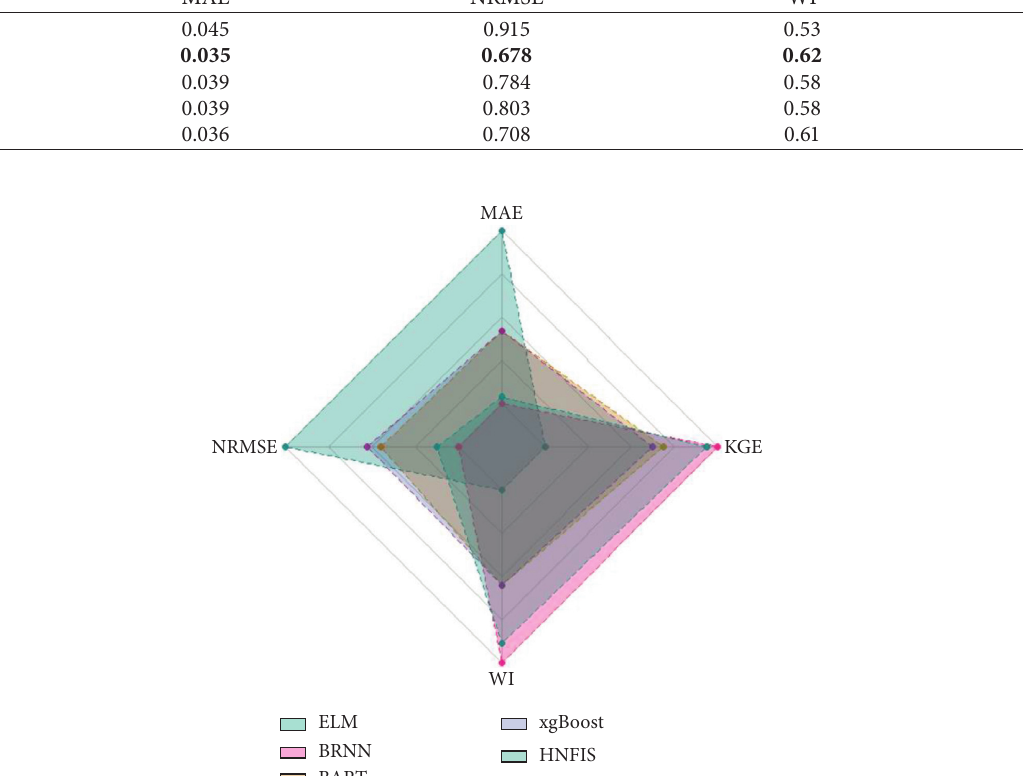
Figure 9: Radar chart showing the relative performance of five ML models considered in the present study based on four statistical metrics.